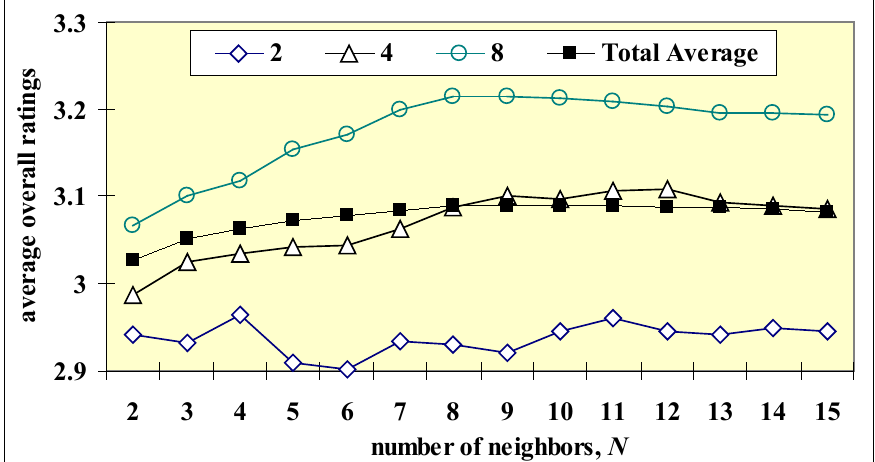
Figure 4 . The average overall ratings with the number of neighbors used in